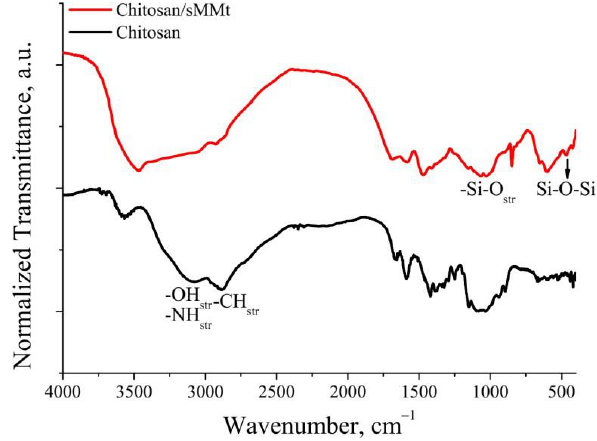
Fig. 4 Proposed illustration of chemical reaction involving chitosan and sMMt. Further, the possible chemical interaction (electrostatic and hydrogen bonding) between methylene blue and Chitosan/SMMt composites is illustrated Fig. 5 indicates the FTIR spectra of chitosan and chitosan/sMMt. The chitosan had a typical absorbance peak at 1669 cm −1 corresponding to the bending vibration of N−H functional group. A broad absorbance band at 3300 cm −1 indicated the O−H stretching vibration. All of chitosan typical absorbance band was clearly observed in chitosan/sMMt composites FTIR spectra. However, the N−H bending vibration peak slightly shifted to 1687 cm −1 which was probably due to the chemical reaction between the amines group of chitosan and oxirane group on the sMMt surfaces via opening ring reaction as illustrated in Fig 4. Additionally, peaks at 1062 cm −1 and 468 cm −1 corresponded to Si−O stretching and Si−O−Si deformation vibration, originated from sMMt.